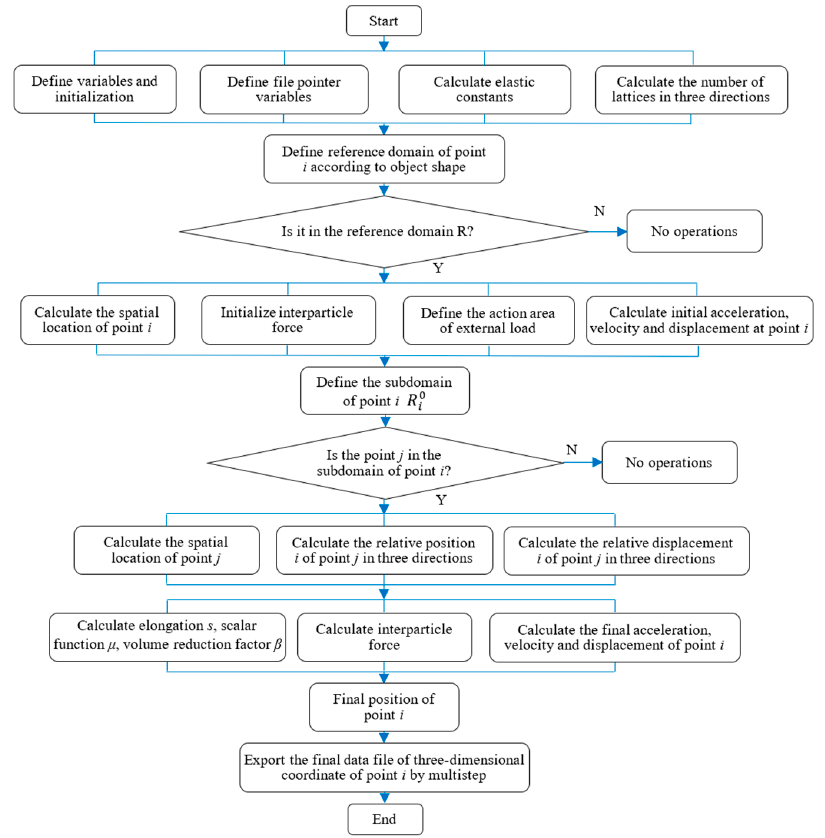
Figure 9. Flow chart of PD numerical analysis program of brittle damage of a turning tool.